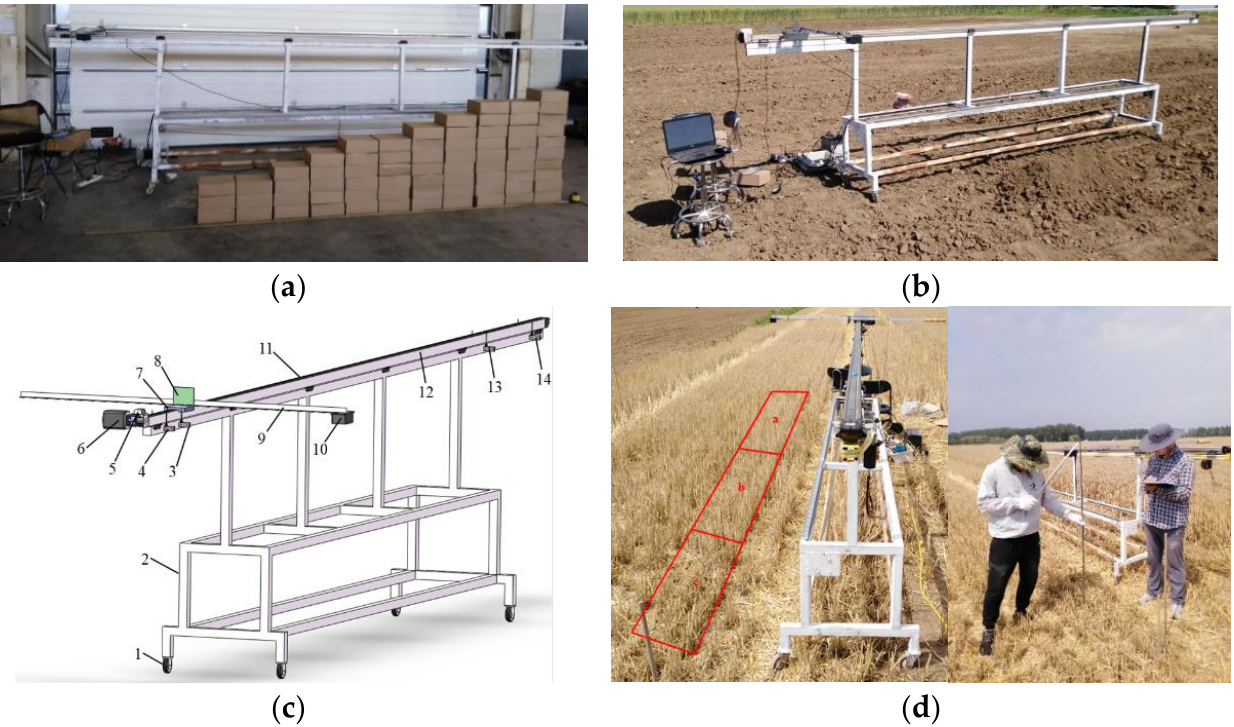
Figure 3. Detection performance experiment of the LiDAR sensor. ( a ) Setup for the step detection experiment. ( b ) Setup for the field ground detection experiment. ( c ) Structural diagram of the experimental platform for H b detection, 1. Mecanum wheel; 2. Support frame; 3. Limit switch 1; 4. Limit switch 2; 5. Laser rangefinder; 6. Stepper motor; 7. Sliding block; 8. Laser-reflecting plate; 9. Sensor fixation bar; 10. LiDAR sensor; 11. Synchronous belt; 12. Sliding track; 13. Limit switch 3; 14. Limit switch 4. ( d ) Setup for the height detection experiment in a WS field.